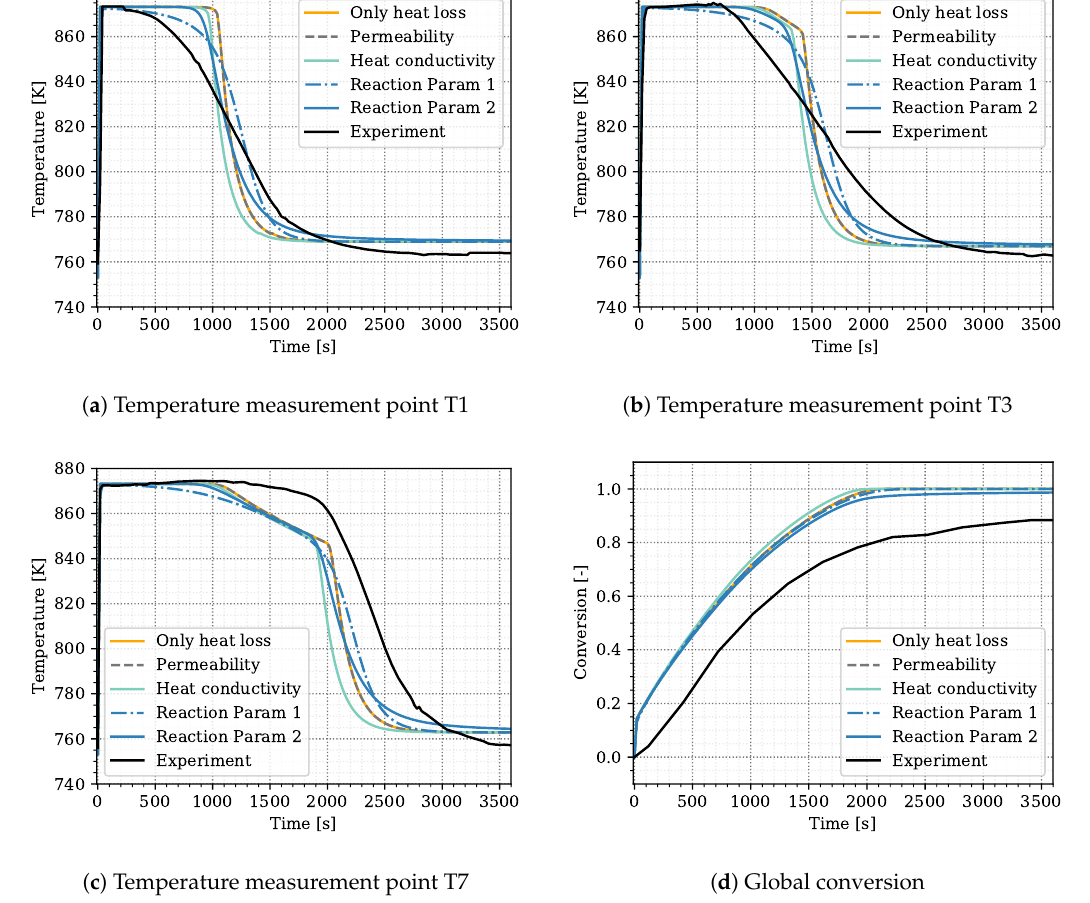
Figure 2. Preliminary simulation results to identify the optimization parameters. In black: experimental values from Refer- ence [31] as reference; Simulation cases: “Only heat loss” is simulated with the standard parameters at constant permeability. “Permeability” applies a permeability change due to porosity alteration, “Heat conductivity” uses different values for solid heat conductivity for CaO and Ca(OH) 2 , “Reaction Param 1” applies a reduced reaction rate constant and “Reaction Param 2” introduces the constant term k R ,2 to the reaction kinetics. The parameters for each simulation case are listed in Table 4. Table 4. Summary of the simulation cases displayed in Figure 2. The units of the parameters are listed in Table